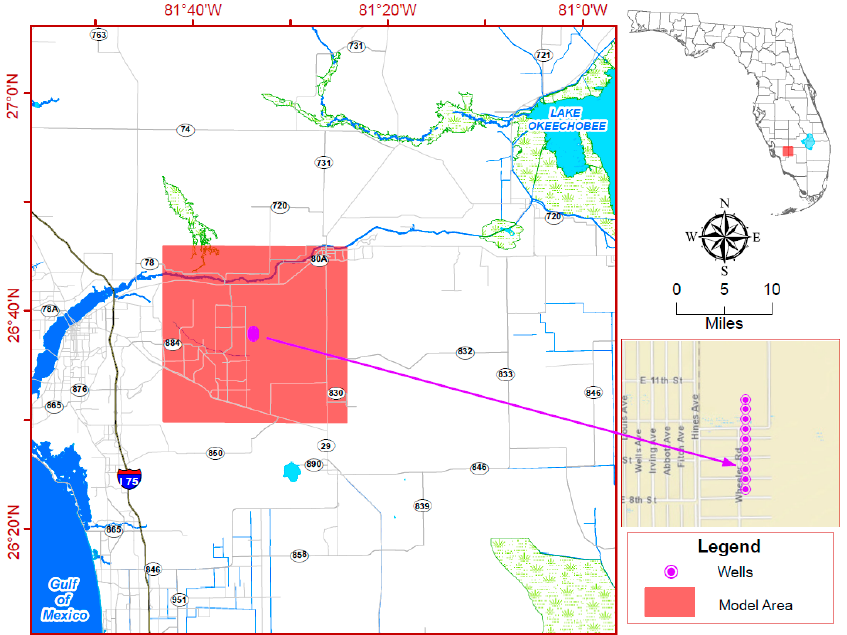
Figure 5. Map showing the groundwater model area, Lehigh Acres and the MAR wells are located along the western boundary of the reservoir south of SR-80. They run in a north-south orientation at the boundary between the Lee and Hendry